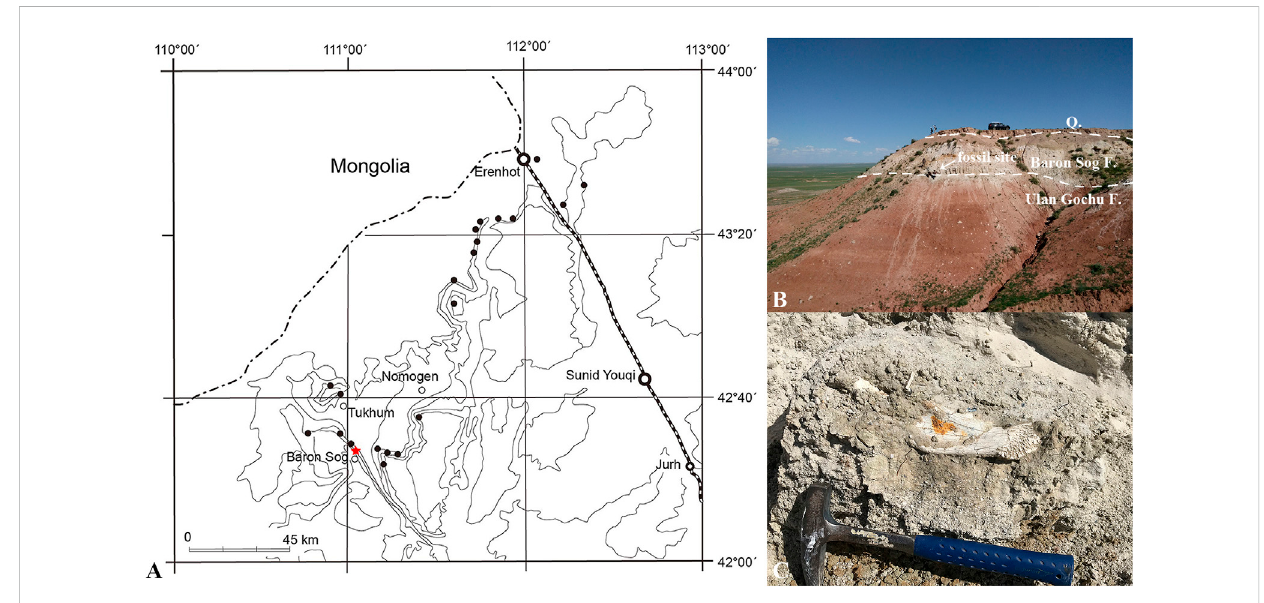
FIGURE 1 Locality bearing Lonchocyon qiui gen. et sp. nov. (IVPP V 28616) from the late Eocene of the Baron Sog Formation, Erlian Basin, Inner Mongolia, China. (A) Topographic map showing the fossil localities in the Erlian Basin with Haerhada marked by a red star, modi fi ed from Wang et al. (2012). (B) Outcrop of the fossil site showing the Baron Sog Formation and underlying Ulan Gochu Formation; (C) the lower jaw of IVPP V 28616 in situ .